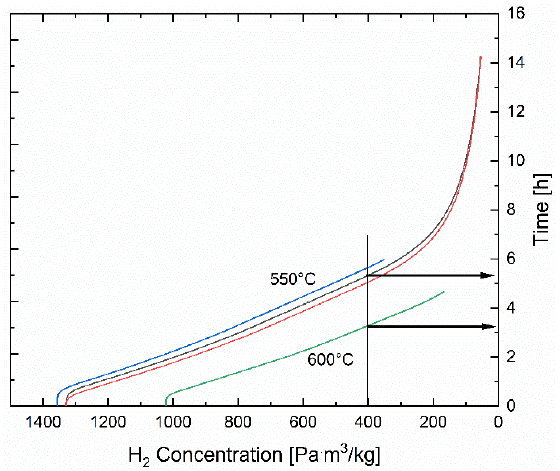
Figure 20. Trend of the gas inventory inside the getter during regenerations performed at different temperatures (represented by different colors). For example, the regeneration reduced to an inventory of 400 Pa·m 3 /kg will take 5–6 h at 550 °C, but only 3 h at 600 °C.